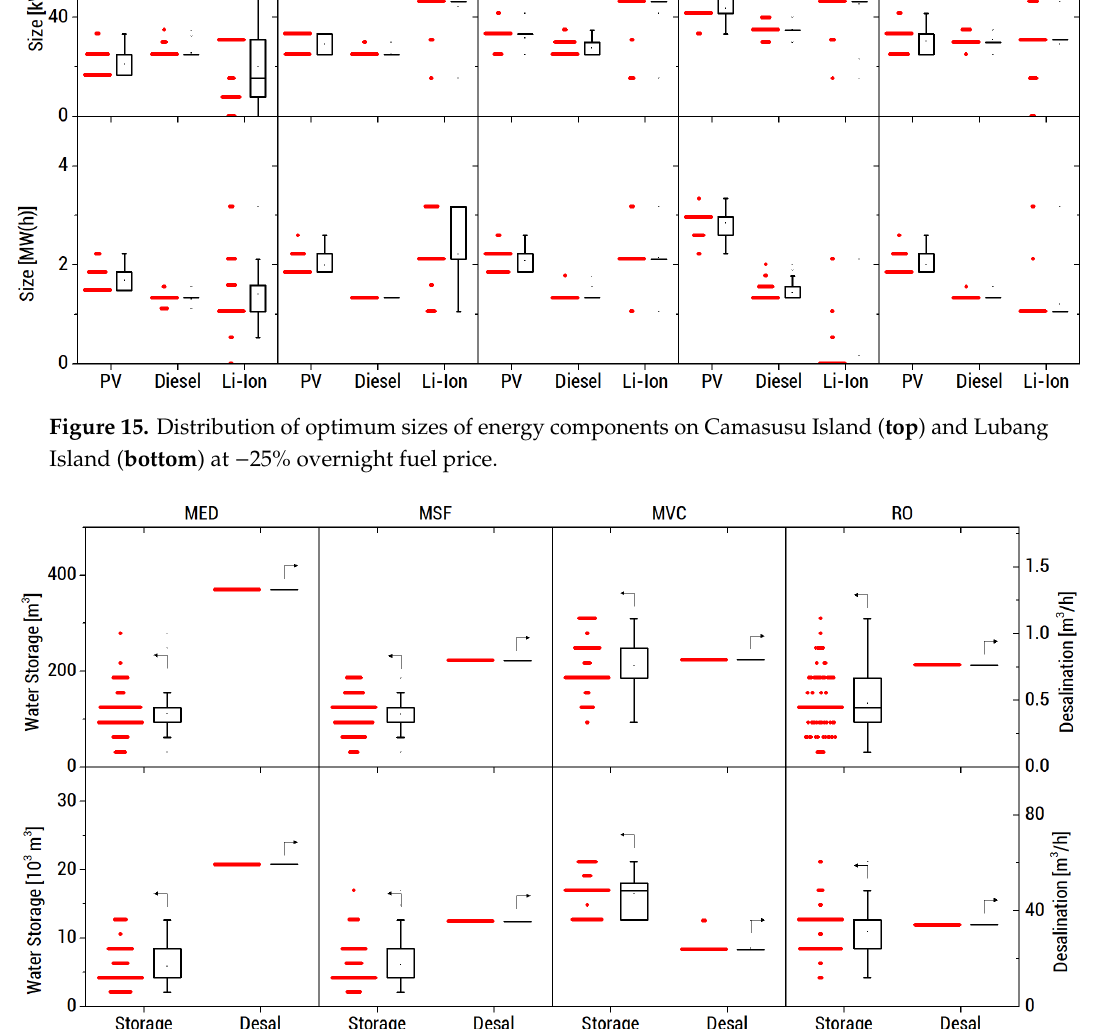
Figure 17. Distribution of optimum LCOE and LCOW on Camasusu Island (top) and Lubang Island (bottom) at −25% overnight fuel price. There is minimal uncertainty for these metrics. 3.4.2. +25% Overnight Fuel Cost At a 25% increase in overnight diesel and coal cost, all systems have large Li-ion BESS installation sizes (Figure 18) preferring RE-favored generation due to prohibitive diesel costs. Figure 19 also shows minimal uncertainty in optimum storage sizes, confirming that RE-favored generation is favored. Generation costs have increased (Figure 20) especially in MVC systems, wherein diesel is used for energy generation, which in turn powers the MVC plant. This is less efficient that MED and MSF, which use the fuel directly.